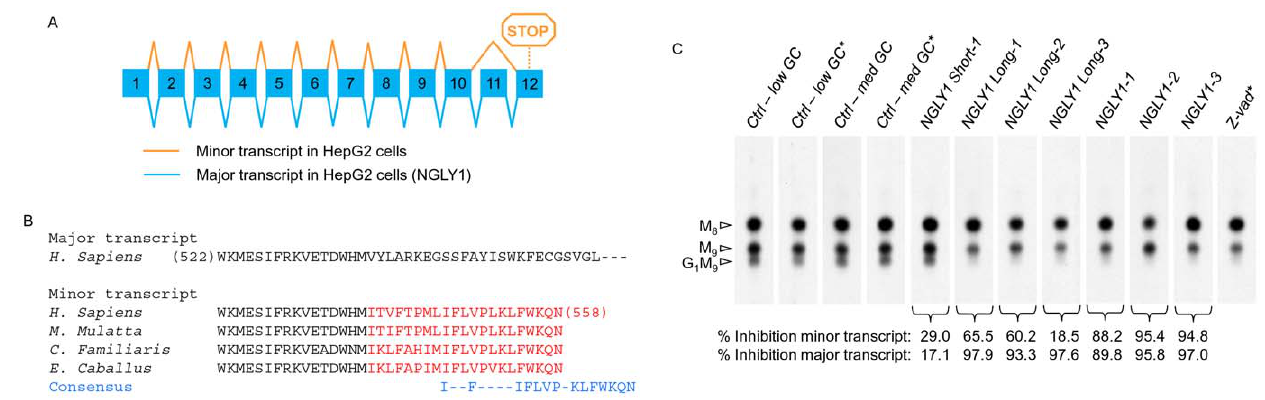
Figure 4. Alternative NGLY1 transcripts and the impact of their down regulation on fOS generation in HepG2 cells. A. Genomic organization of the human NGLY1 gene and alternative transcripts found in HepG2 cells. The major transcript found in HepG2 cells is indicated in blue and corresponds to the already published NGLY1 mRNA sequence (NM_018297.3). A minor transcript indicated in orange is generated by skipping of exon 11 (NM_001145295.1). B. Partial alignment of homologous Ngly1p sequences (amino acids 522–558) encoded by the minor transcript and comparison with the corresponding region of the major NGLY1 transcript (accession numbers: Macaca mulatta ; XP_001092914, Equus caballus ; XP_001492093, Canis lupus familiaris ; DN746692.1). Note that the isoform encoded by the minor transcript contains 21 amino acids in its COOH terminal which are not found in the peptide sequence encoded by the major transcript. C. HepG2 cells were transiently transfected with the different siRNA duplexes designed to silence either or both NGLY1 transcripts (see Table S1). Total RNA were extracted three days later and the mRNA levels of each specific transcript were analyzed by QPCR. In parallel, HepG2 cells were co transfected with ENG-3 and the different siRNA duplexes targeting the two NGLY1 transcripts. As described in Materials and Methods, because of the variable GC content of the different RNAi duplexes, two negative control siRNA duplexes with either medium (med GC) or low GC (low GC) content were used. After 3 days cells were pulse-radiolabeled with [2- 3 H]mannose for 30 min. In some experiments, cells transfected with ENG-3 alone or with control RNAi duplexes were treated with either Z-vad-fmk (40 m M) dissolved in DMSO (Z-vad*) or DMSO alone (*) for 45 min prior to, and during the radiolabeling period. Subsequently, [2- 3 H]fOS, [2- 3 H]LLO and [2- 3 H]Glycoproteins were extracted, purified and quantitated, and [2- 3 H]fOS were analysed by TLC. In order to take into account the differences in total incorporation of radiolabel into cells cultivated under the different conditions, a fraction of total fOS was loaded onto the TLC according to the ratio of the total cellular radioactivity for a given incubation to that recovered from the incubation incorporating least radioactivity. The scanned TLC lanes are from the same fluorograph, but due to uneven migration, the scans were aligned manually to facilitate interpretation of data. The migration positions of standard oligosaccharides are shown to the left of the chromatograms and the abbreviations used are as described in Fig 1. The percent inhibition of the major and minor NGLY1 transcripts provoked by the different RNAi duplexes was calculated using the QPCR data and is indicated underneath the appropriate lanes. This experiment was performed once.